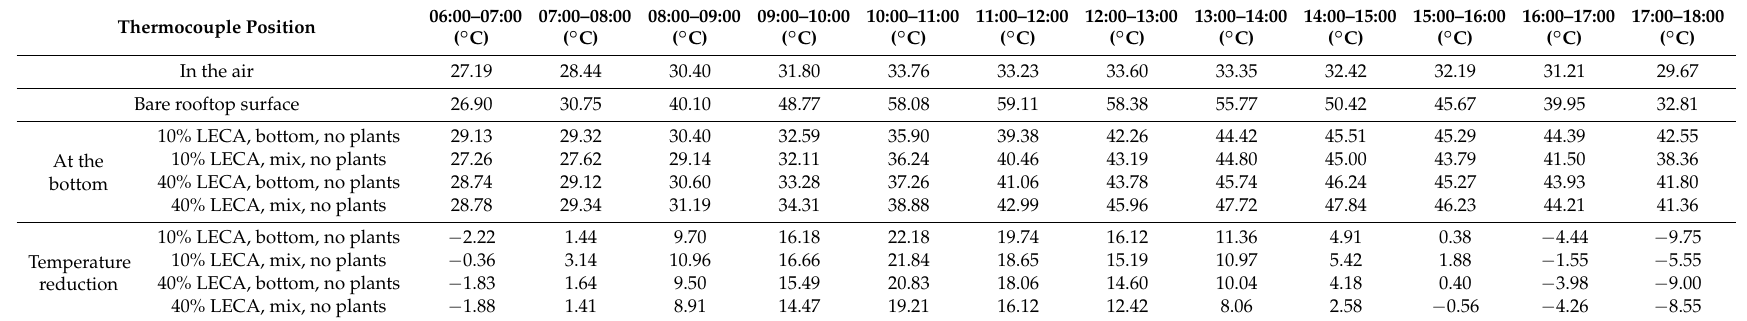
Table 9. Temperatures at the bottom of the roofs and temperature reductions in the cases of roofs with 10% and 40% LECA laid at the bottom without plants, and of 10% and 40% LECA mixed with the soil without plants (24 September 2017 06:08:41 to 24 September 2017 17:58:41). Thermocouple